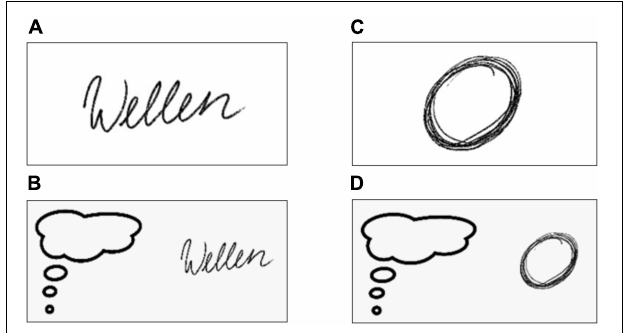
FIGURE 1 | Instruction images for the four conditions of the fMRI task. The subjects wrote the German word “Wellen” (A) or imagined to write this word (B) . In parallel, the subjects drew circles (C) or imagined to draw circles